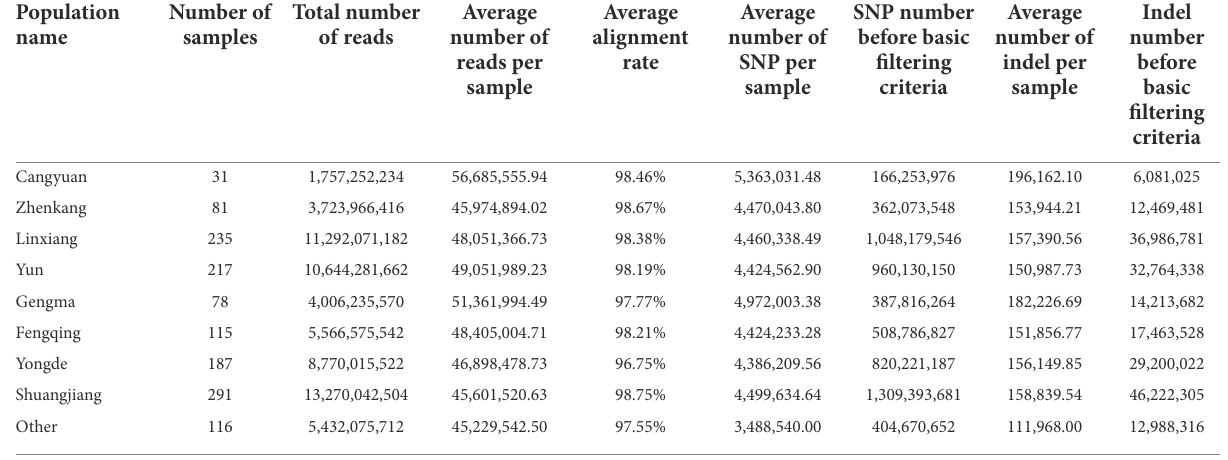
TABLE 1 Sequencing and genetic variation information of tea from different geographic regions.